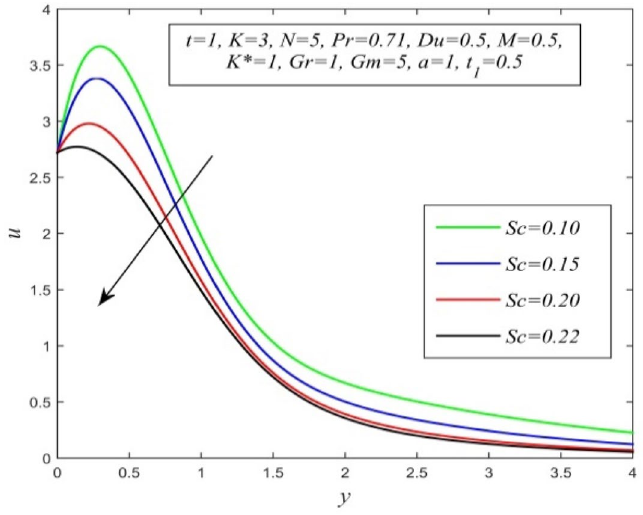
Figure 15. u versus y for different Sc and t = 1, K = 3, N = 5, Pr = 0.71, Du = 0.5, M = 0.5, K* = 1, Gr = 1, Gm = 10, a = 1, t 1 = 0.5.